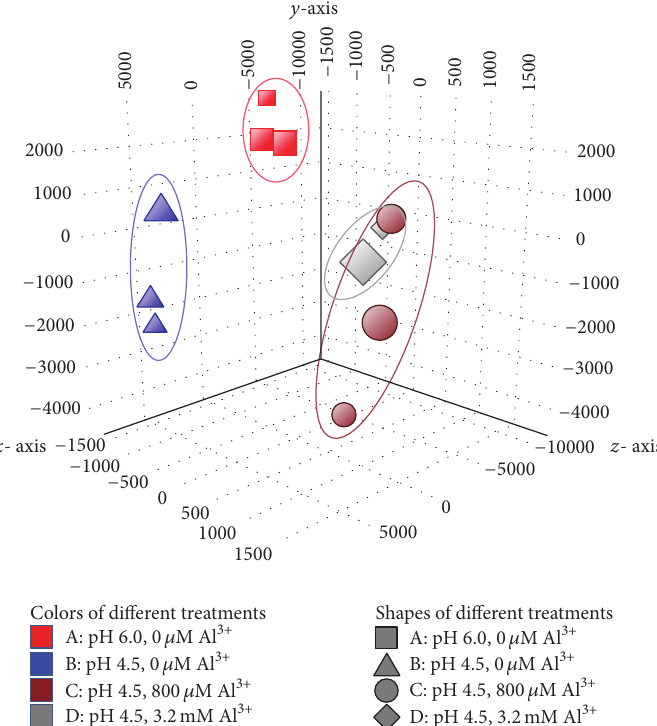
Figure 2: Principle component analysis for microarray data. Principle component analysis of intact genes detected by microarray from samples under different Al treatments for 60h. The colored graph shows all data points projected in the three-dimensional space formed by three coordinates after rotation. Each data point represents an independent Al treatment, with the red colored square representing samples treated with pH 6.0 and 0mM Al, the blue triangle representing samples treated with pH 4.5 and 0 mM Al, the brown circle representing samples treated with pH 4.5 and 0.8 mM Al and the gray rhombus representing samples treated with pH 4.5 and 3.2 mM Al. Samples with the same treatment are closely related and can be encircled together.